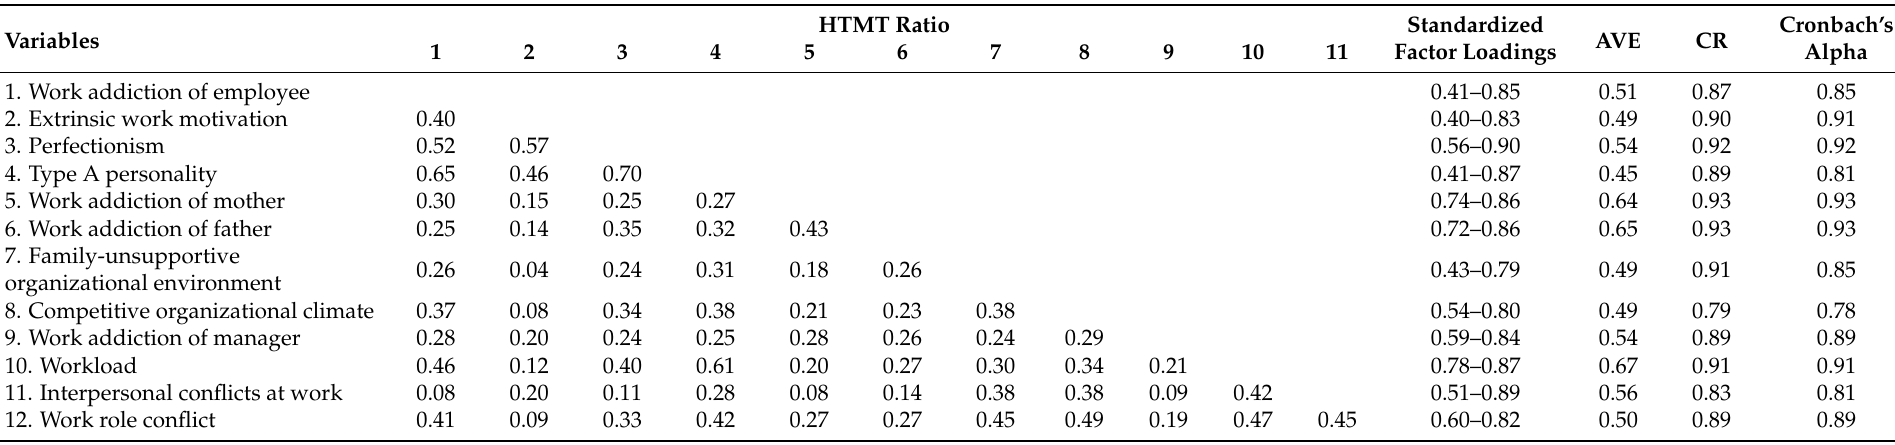
Table 1. Reliability and validity of instruments.